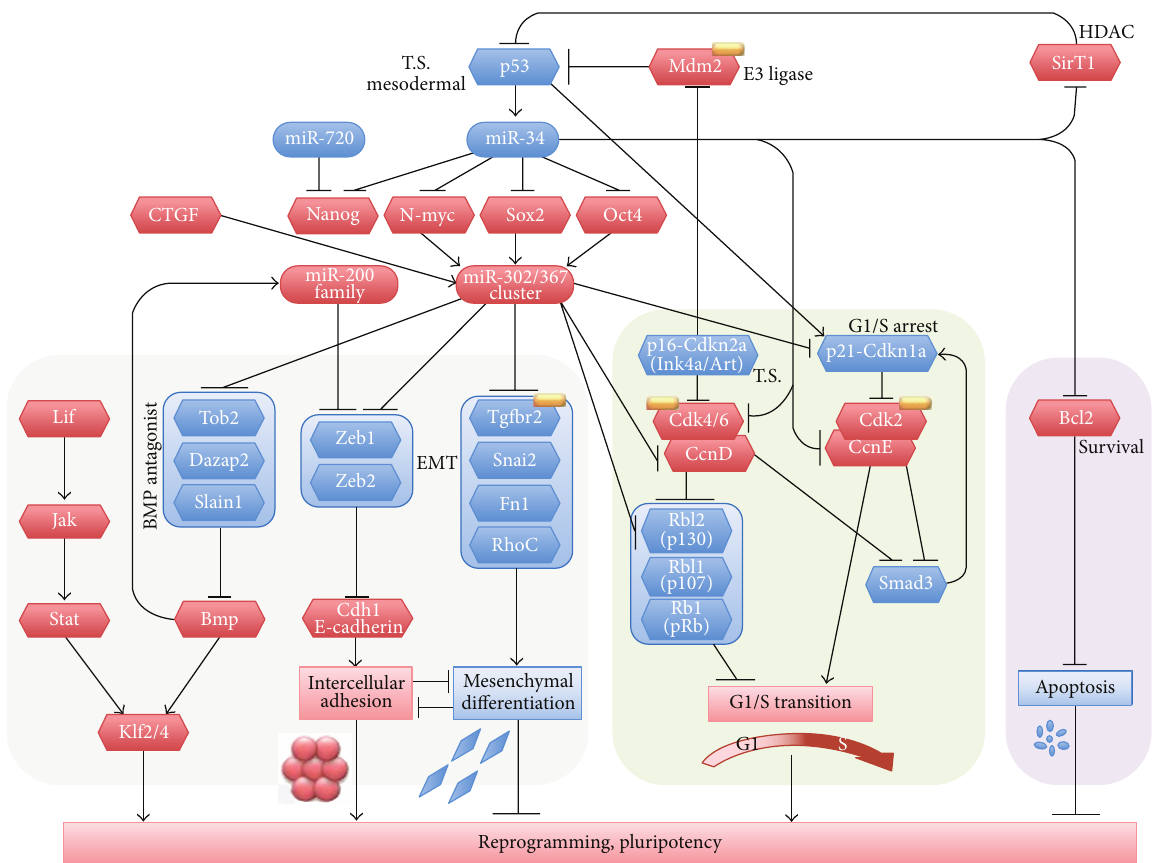
Figure 1: Summary of published intermolecular interactions featuring pluripotency-associated miRNAs and their targets. Factors positive to induction of pluripotency was shown in red. Inhibitory factors to induction of pluripotency was shown in blue. Epithelial-mesenchymal transition (EMT), cell cycle, and cell death and survival were featured. Molecularly targeted drugs are shown with drug marks. T.S., tumor